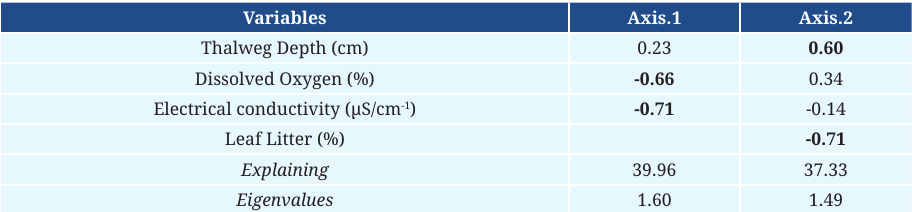
TABLE 1 | Loadings of the first two PCA axes with the environmental variables recorded in the seven streams of a catchment of the Guamá River in Capitão Poço, Pará State, Brazil. Variables